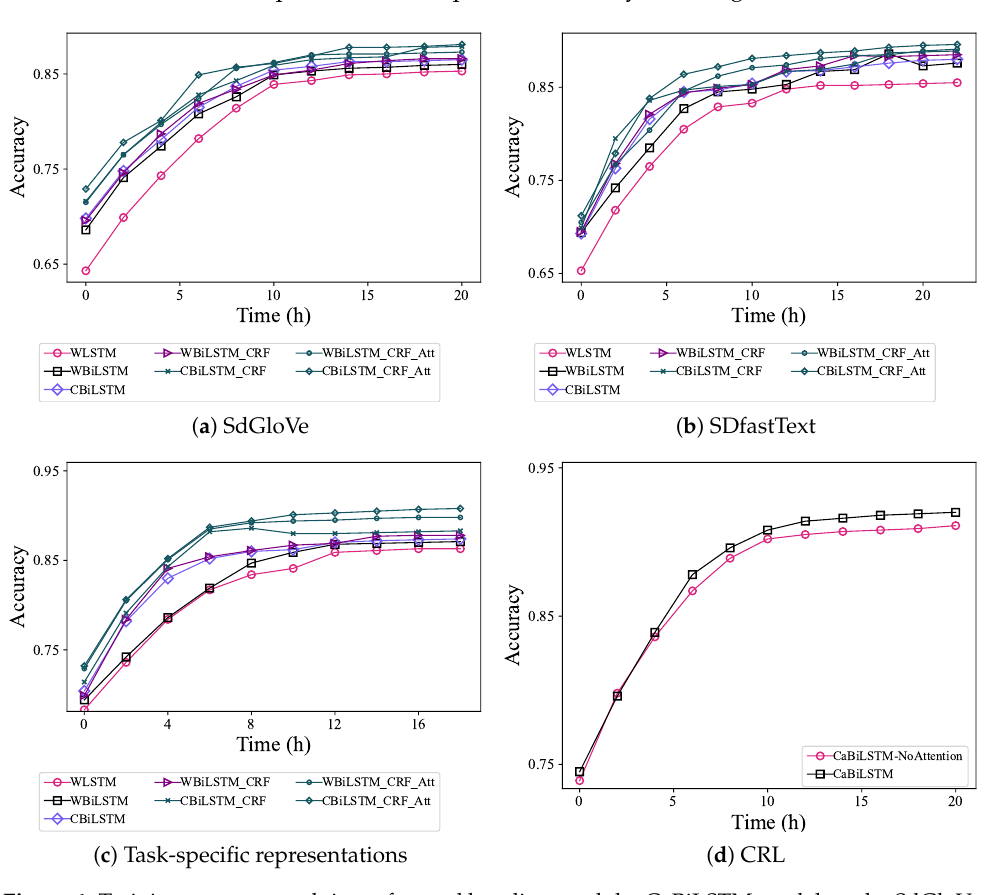
Figure 4. Training accuracy and time of neural baselines and the CaBiLSTM model on the SdGloVe, SdfastText, task-specific, and CRL-based